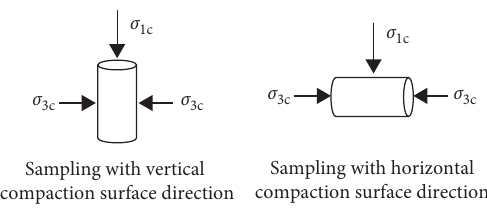
Figure 4: Stress state of compacted